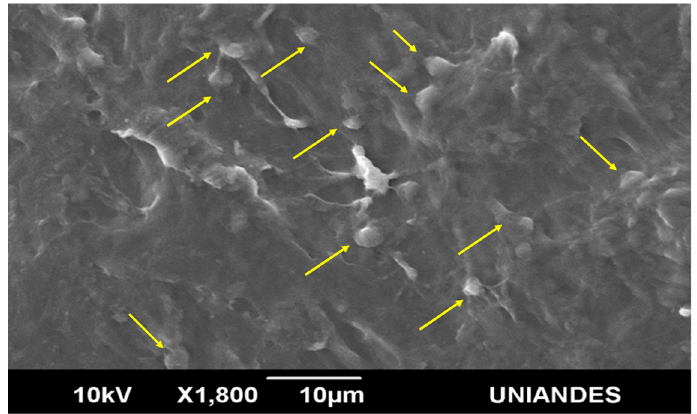
The cytotoxicity was determined via MTT colorimetric assay relative to the negative control, which was uncirculated EGM-2 medium (UM). Cells treated with circulated EGM-2 medium (for 72 h) evidenced a 93.4 ± 2.2% cell viability, while cells treated with the positive control (DMSO 10%) in EGM-2 exhibited a 5.3 ± 0.96% viability. There is no statistically significant difference between the circulated medium and the negative control according to statistical analysis determined by one-way ANOVA followed by a Tukey test ( n = 3 for each experiment).